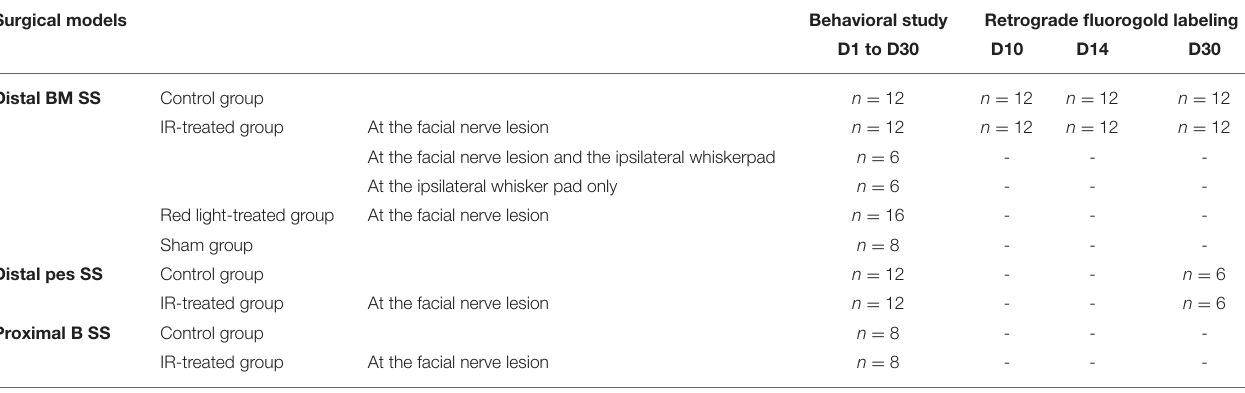
TABLE 1 | Experimental design. Surgical models